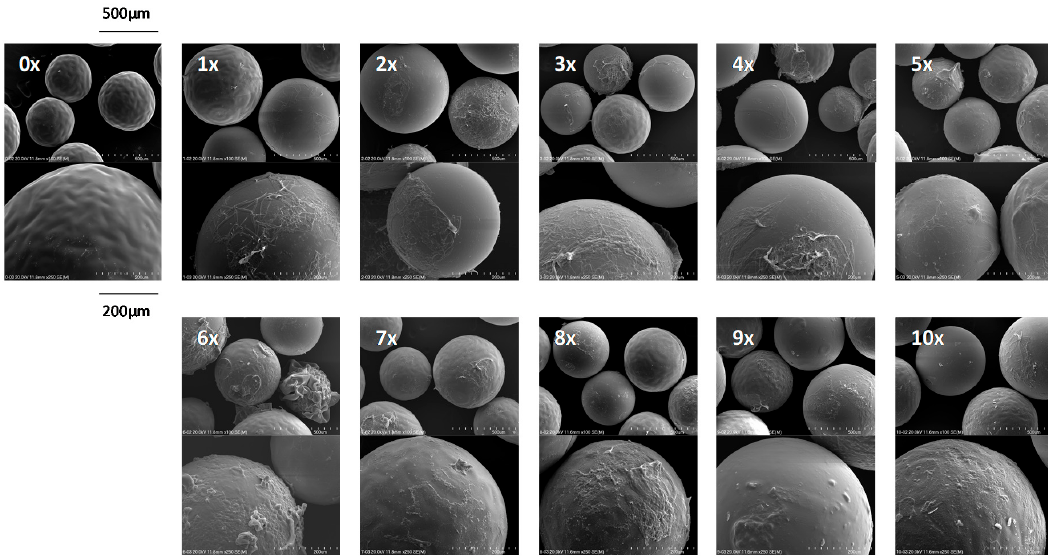
Figure 7. SEM microphotographs of Amberlite IR-120 catalyst before epoxidation reaction (0×) and after each reaction (1×–10×).